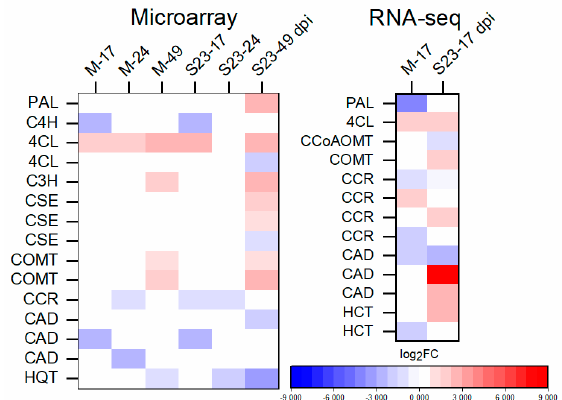
Figure 5. Heat map of log 2 FC of main genes related to lignin biosynthesis identified by microarray and RNA-seq.